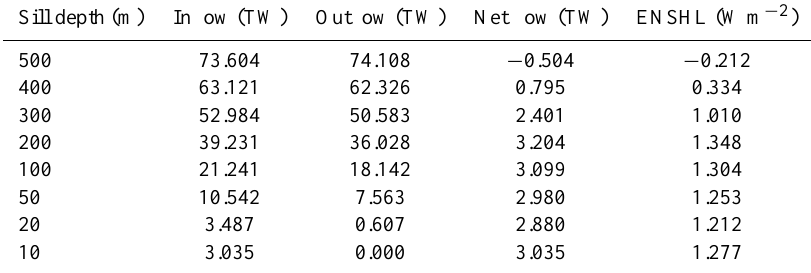
Table 2. Overview of heat transport through the Strait of Gibraltar. ENSHL: equivalent net surface heat